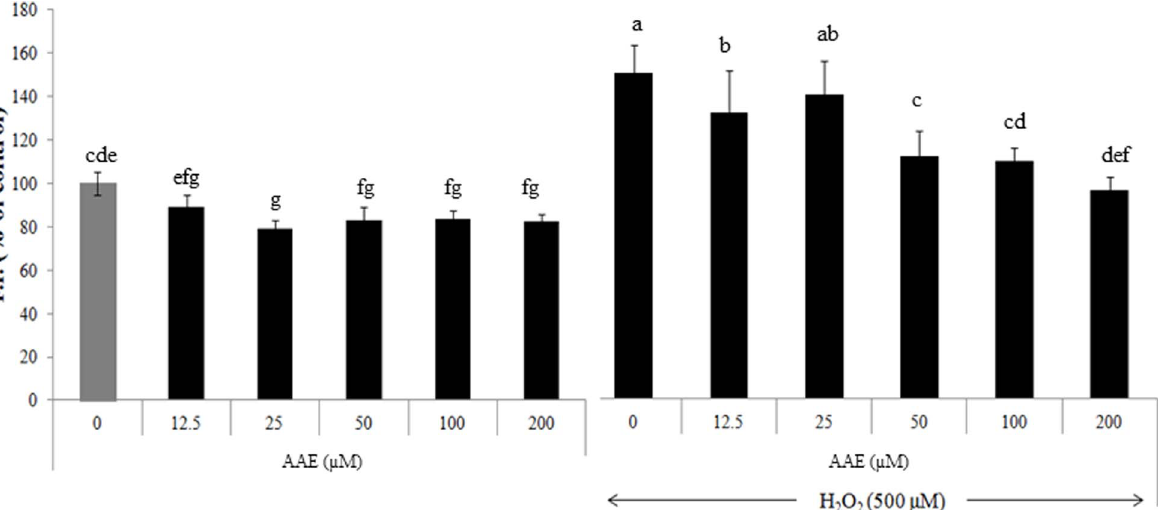
Figure 1. Reduction of intracellular ROS level by AA extract. Human hepatoma HepG2 cells were exposed to either AA extract or AA extract plus hydrogen peroxide (500 m M), followed by measuring fluorescence generated by adding DCFDA. Values are means 6 SD (n=10). Means without